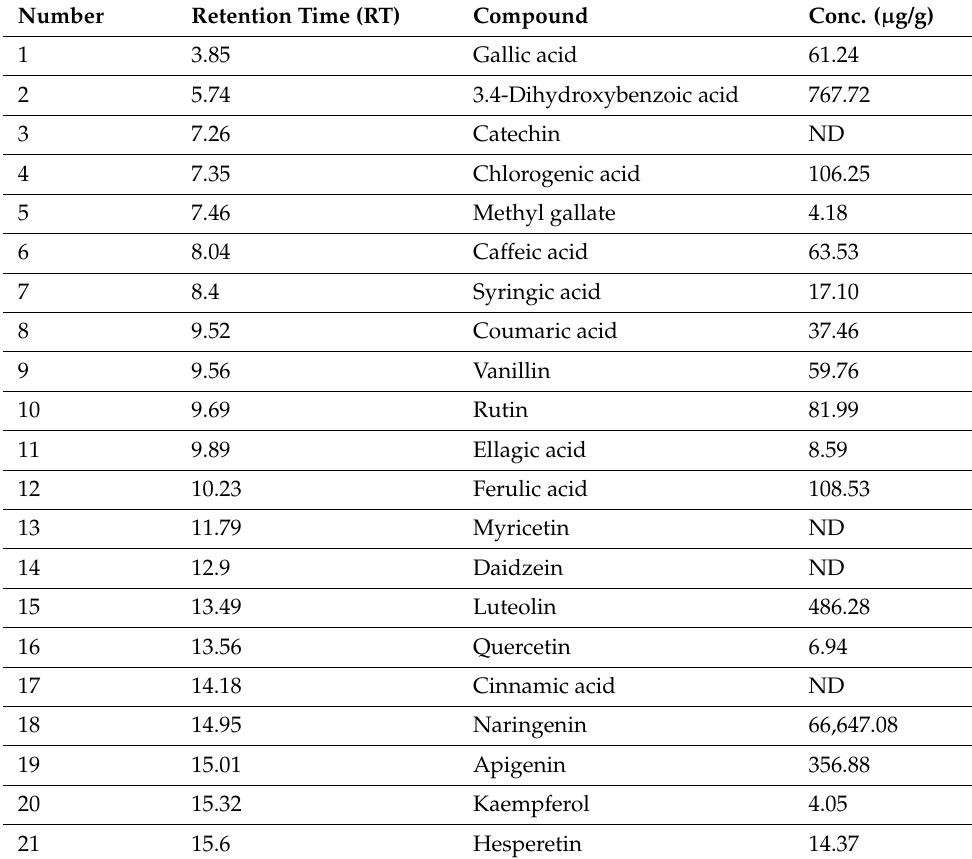
Figure 1. Liquid chromatography-electrospray ionization–tandem mass spectrometry (LC-ESI- MS/MS) of ELLE. Table 1. Chemical composition analysis of ELLE’s compounds.